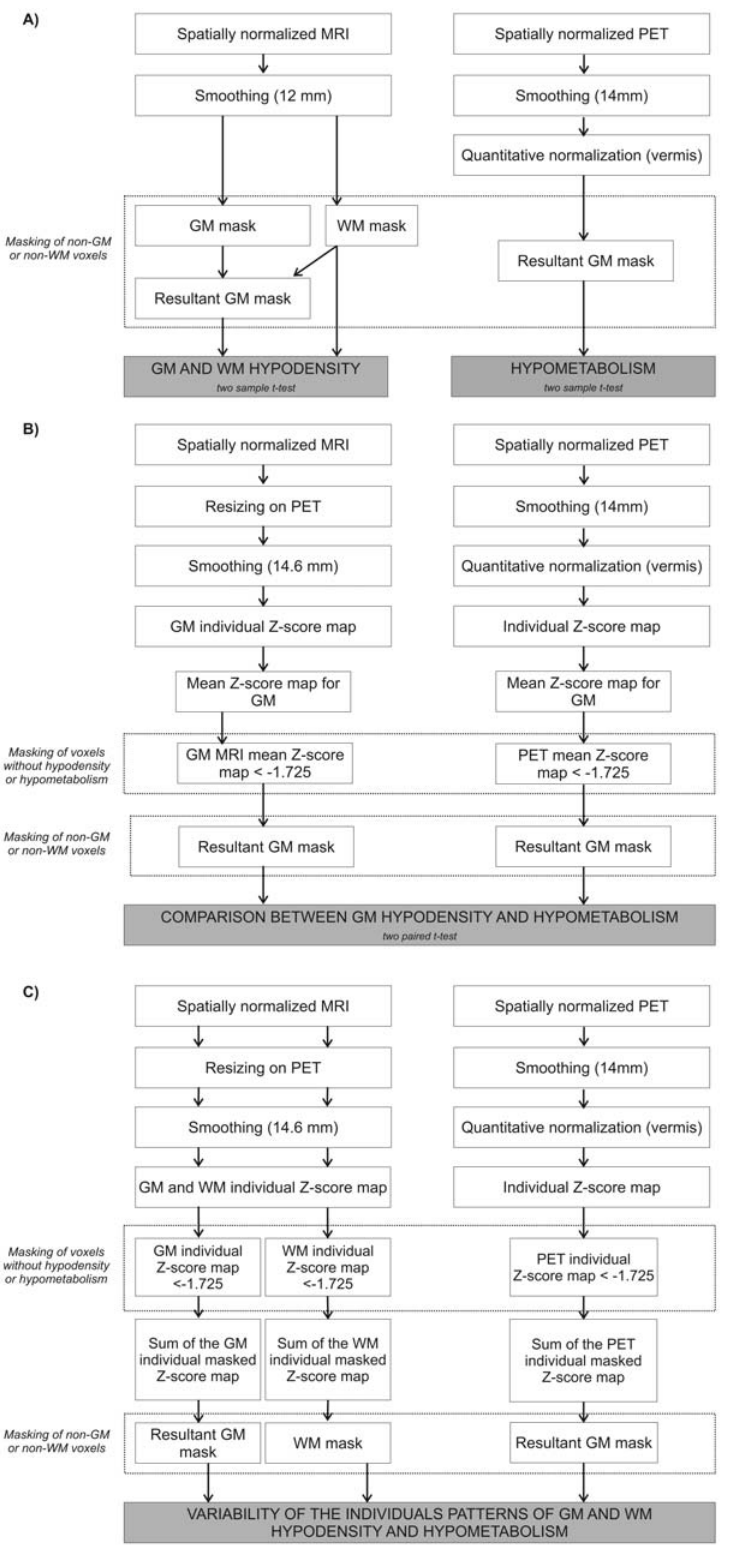
Figure 4. Schematic representation of the procedures for analyzing MRI and PET data after registration. A: Procedure for analyses of GM and WM hypodensity and GM hypometabolism; B: Procedure for the direct voxel-based comparison between morphological and metabolism abnormalities; C: Procedure for the analysis of the variability in the individual patterns of hypodensity and hypometabolism.